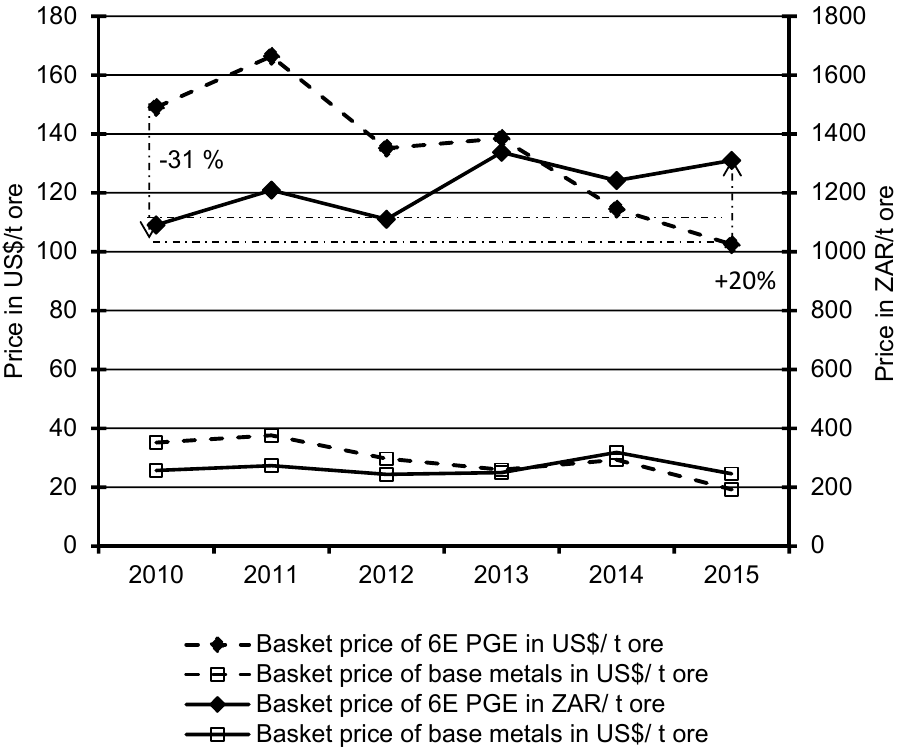
Figure 8. Basket price of 4E PGE ore in US$ and ZAR. Price data obtained from [37,38,132,133].